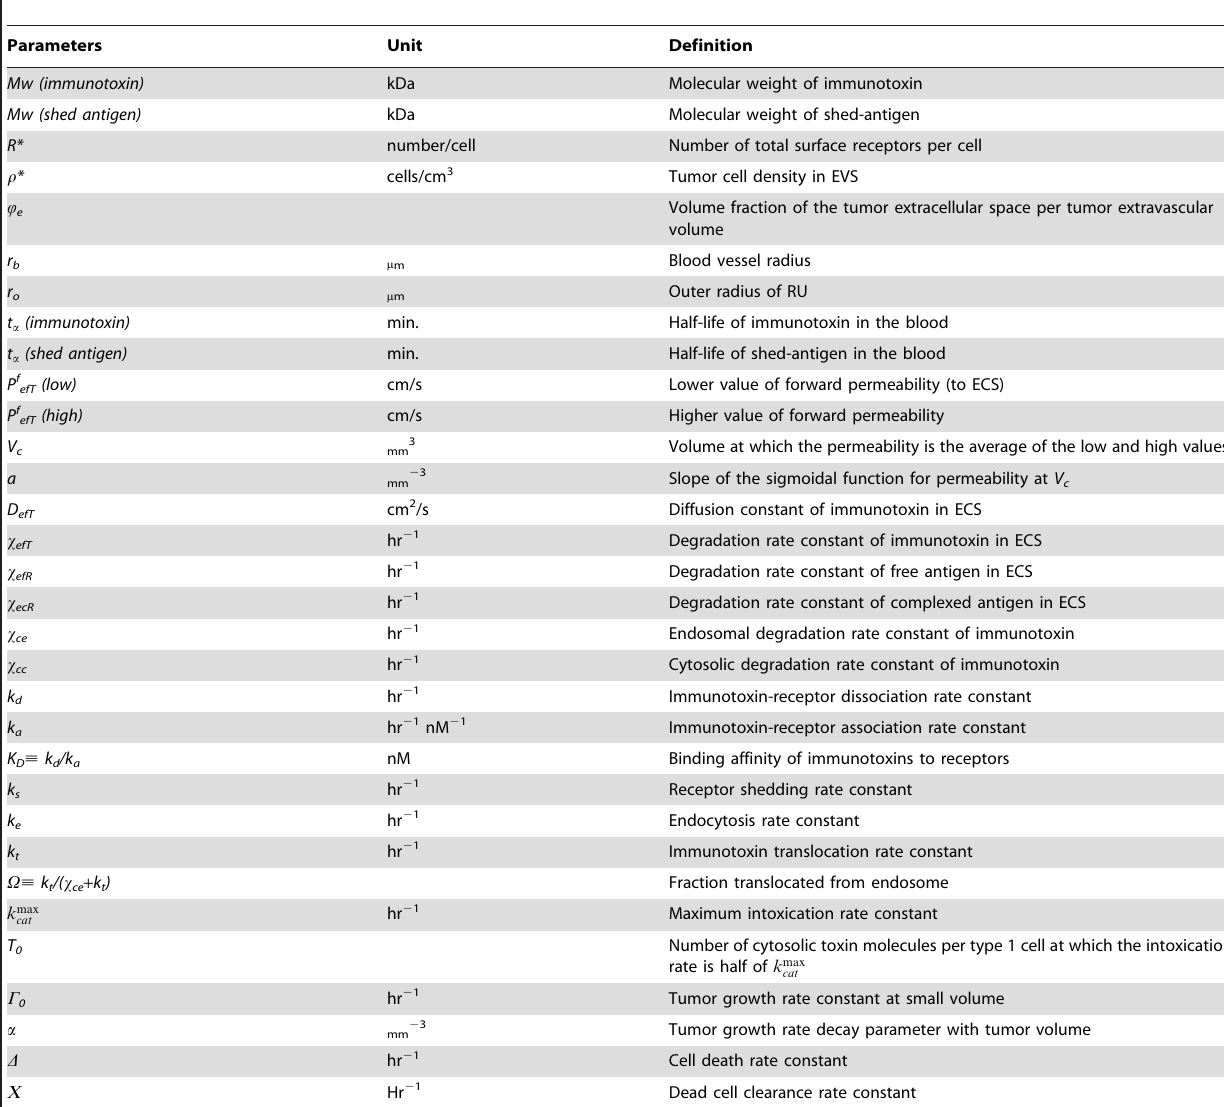
Table 1. Symbols, definitions, and units of the model parameters. (ECS: extra-cellular space).